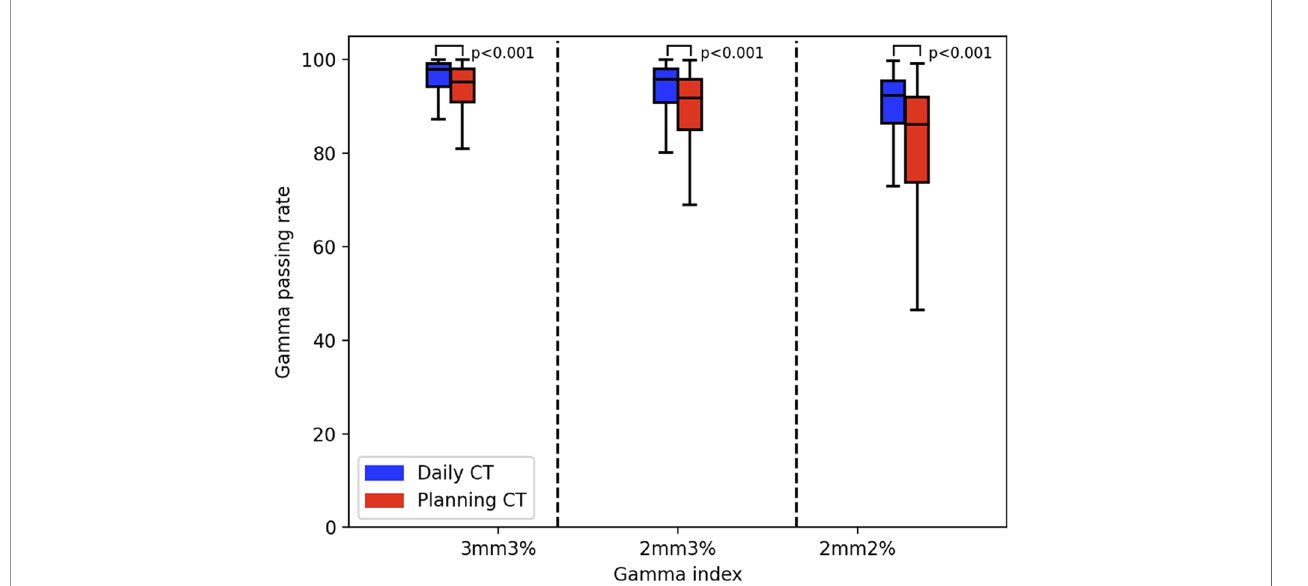
FIGURE 6 | The Gamma analysis results of planning CT (pCT) and daily CT (dCT). The red box diagram represents the pCT results. The blue box represents the dCT